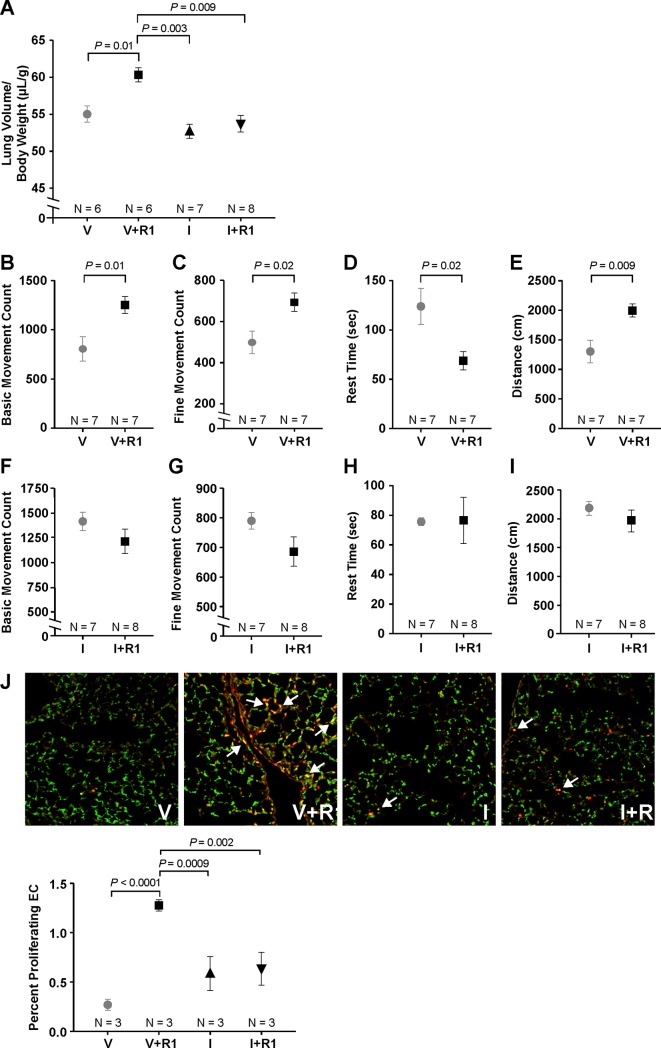
HIF2α neutralization abolished the effect of VEGFR1 on CLG.VEGFR1 treatment (F) again increased lung volume compared to the vehicle control group (V) (A). The administration of PT-2385, a HIF2α inhibitor, had no effect on lung volume without (I) or with (I+R1) VEGFR1. Compared to the V group, mice in the F group demonstrated increased physical activity as evidenced by increased basic and fine movement count (B and C), decreased rest time (D), and increase walking distance (E). These differences disappeared between the I and I+R1 groups (F-I). On IHC, there was an increased number of proliferating endothelial cells (white arrows) in the F group compared to the remaining 3 groups (J). There was no difference in endothelial proliferation between the I and I+R1 groups. Data are expressed as mean ± standard error (SE).